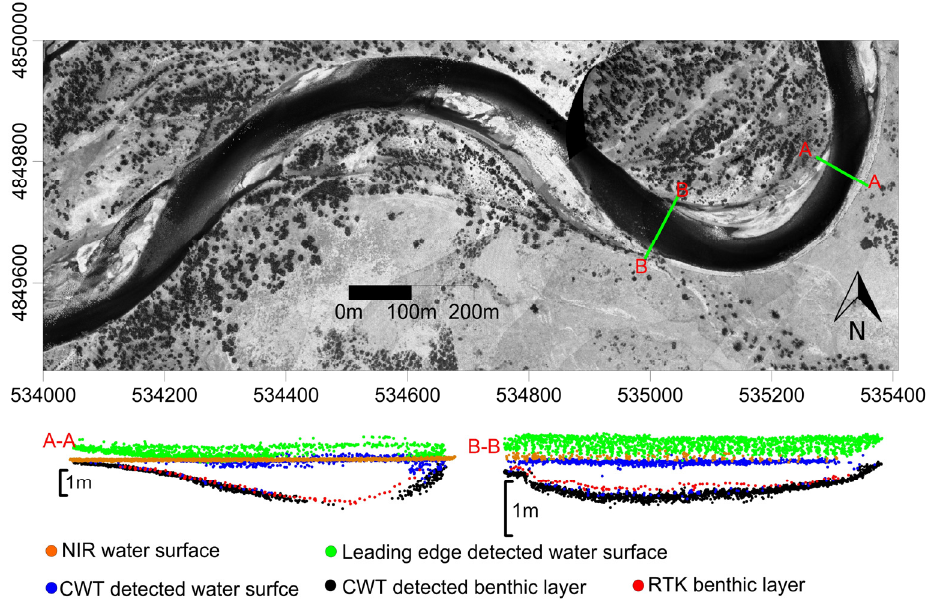
Figure 15. Profiles for leading edge detected water surface on the Rusty Bend of Snake River. The water surface detected with CWT matches the NIR water surface well. Coordinates are in UTM 12N